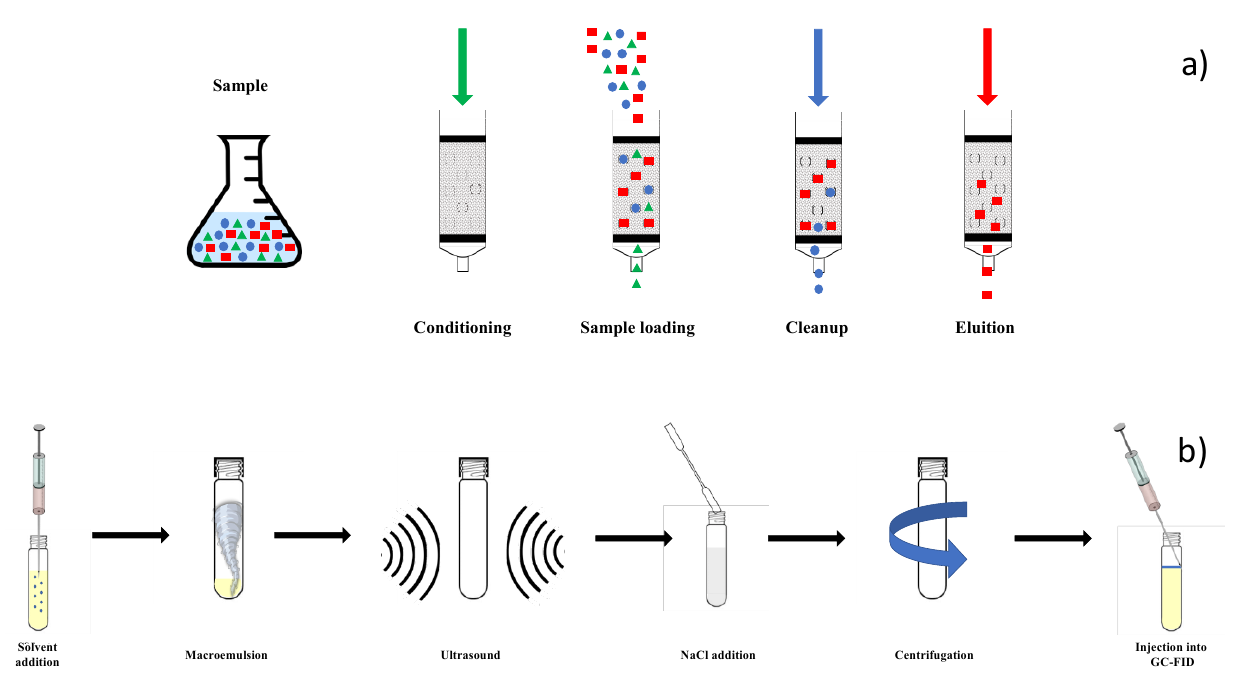
Figure 1. Master schemes of the extraction procedures investigated in this study for analyzing phthalates (PAEs) in hot drinks: ( a ) Solid Phase Extraction (SPE); ( b ) Ultrasound-Vortex-Assisted Dispersive Liquid-Liquid Microextraction (UVA-DLLME).